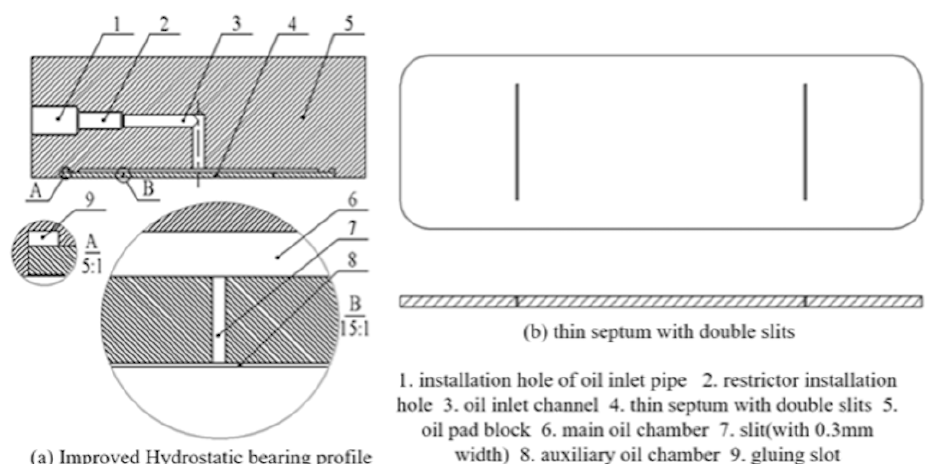
Figure 13. Improved hydrostatic bearing structure.